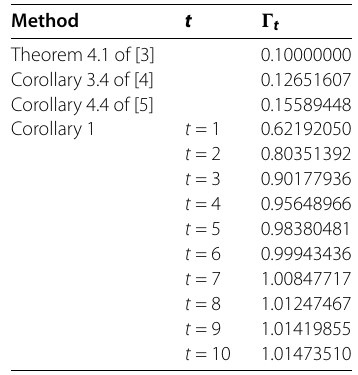
Table 2 The lower upper of τ ( A